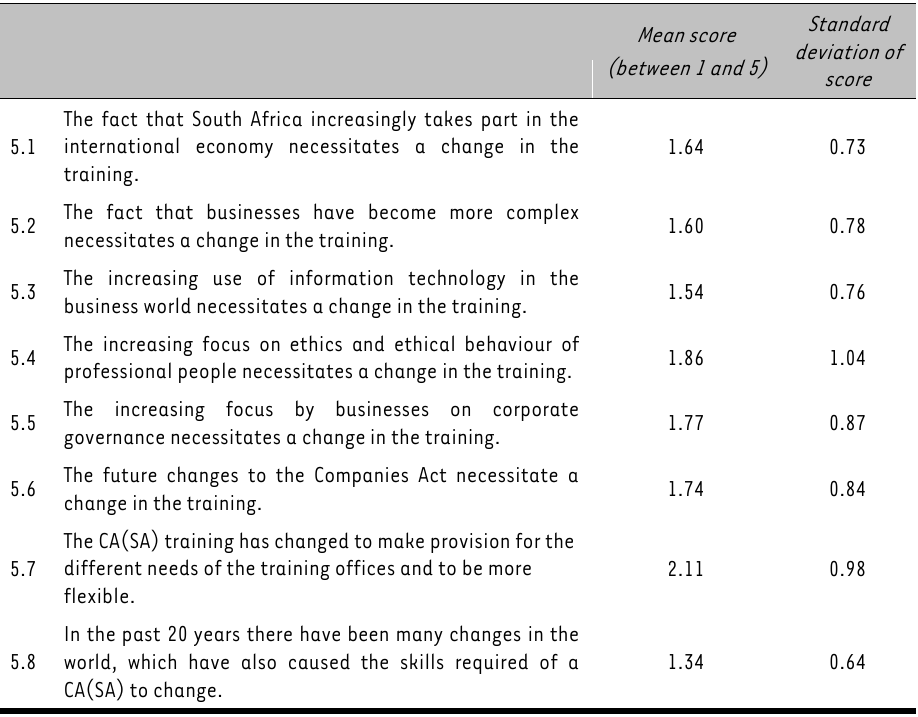
TABLE 5: Perceptions regarding the reasons for the change